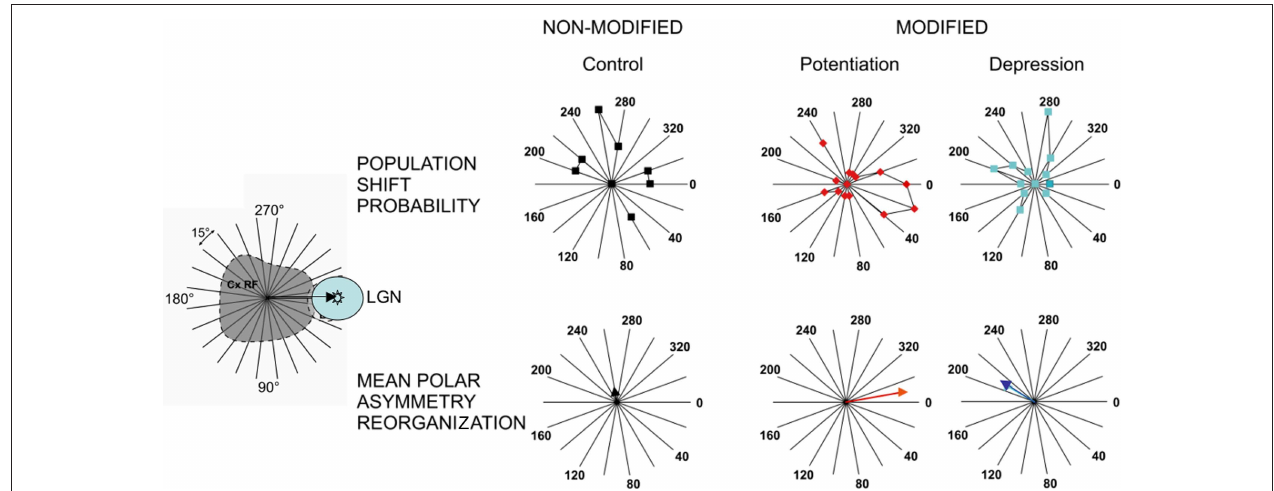
not significantly modified (black), TBS-potentiated (red) or TBS-depressed (blue). Upper panel shows the mean polar plots of RF anisotropy changes, and the lower panel gives the weighted displacement vector (TBS-Non_Modified: IA = 6.6%; DA = 81 ° ; TBS-Potentiated: IA = 31.8%, DA = − 13 ° ; TBS-Depressed: IA = 16.3%, DA = 229 ° ). 0 ° indicates shift of the recorded cortical RF center toward the LGN-RF center, as shown by the arrow in the left